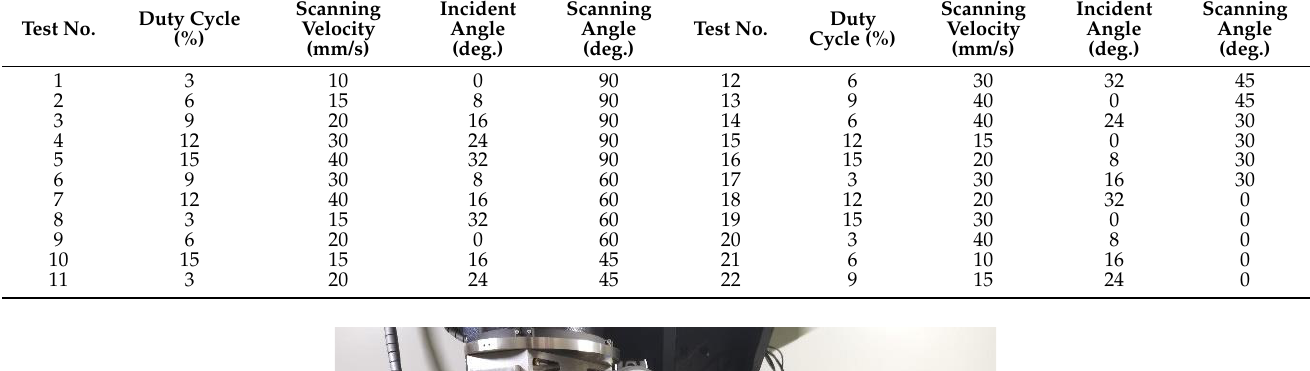
Table 4. Orthogonal test parameters for laser engraving (the laser pulse frequency is 2000 Hz).